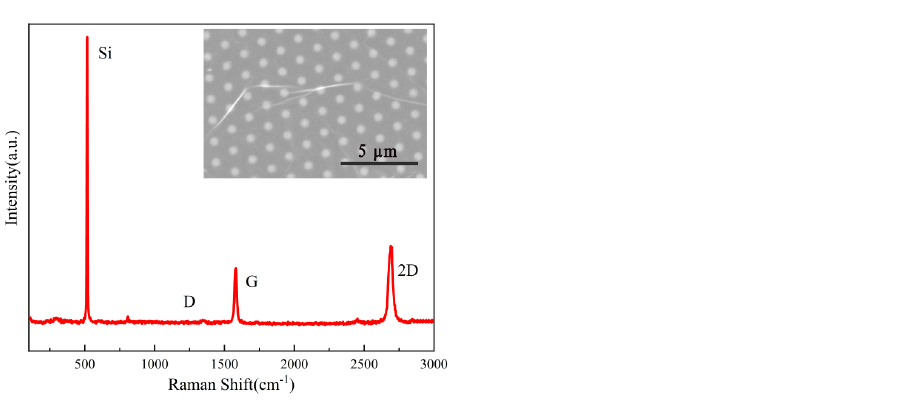
Figure 4. Simulation model of ( a ) planar silicon, ( b ) silicon nanopillars, and ( c ) Si NTCAs.